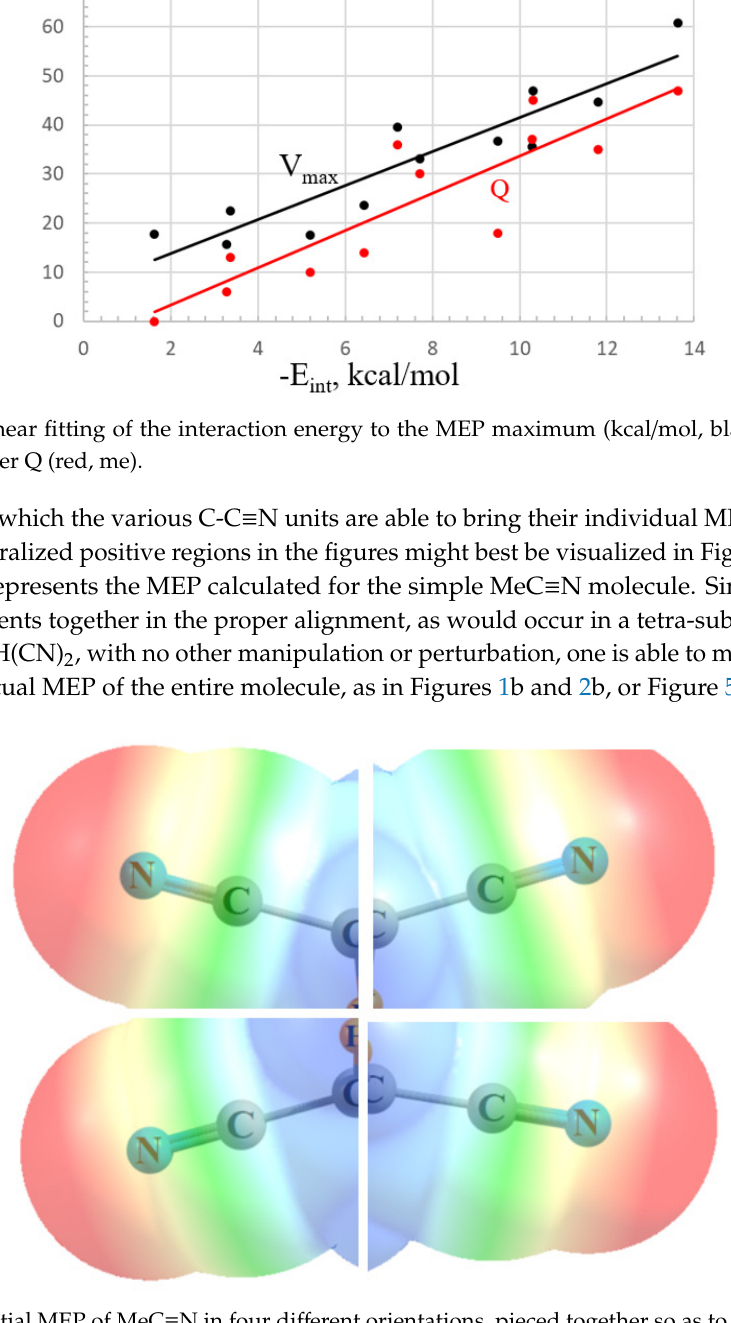
Figure 8. Partial MEP of MeC ≡ N in four di ff erent orientations, pieced together so as to compare with the MEP of (CN) 2 HC-CH(CN) 2 in Figure 2b.